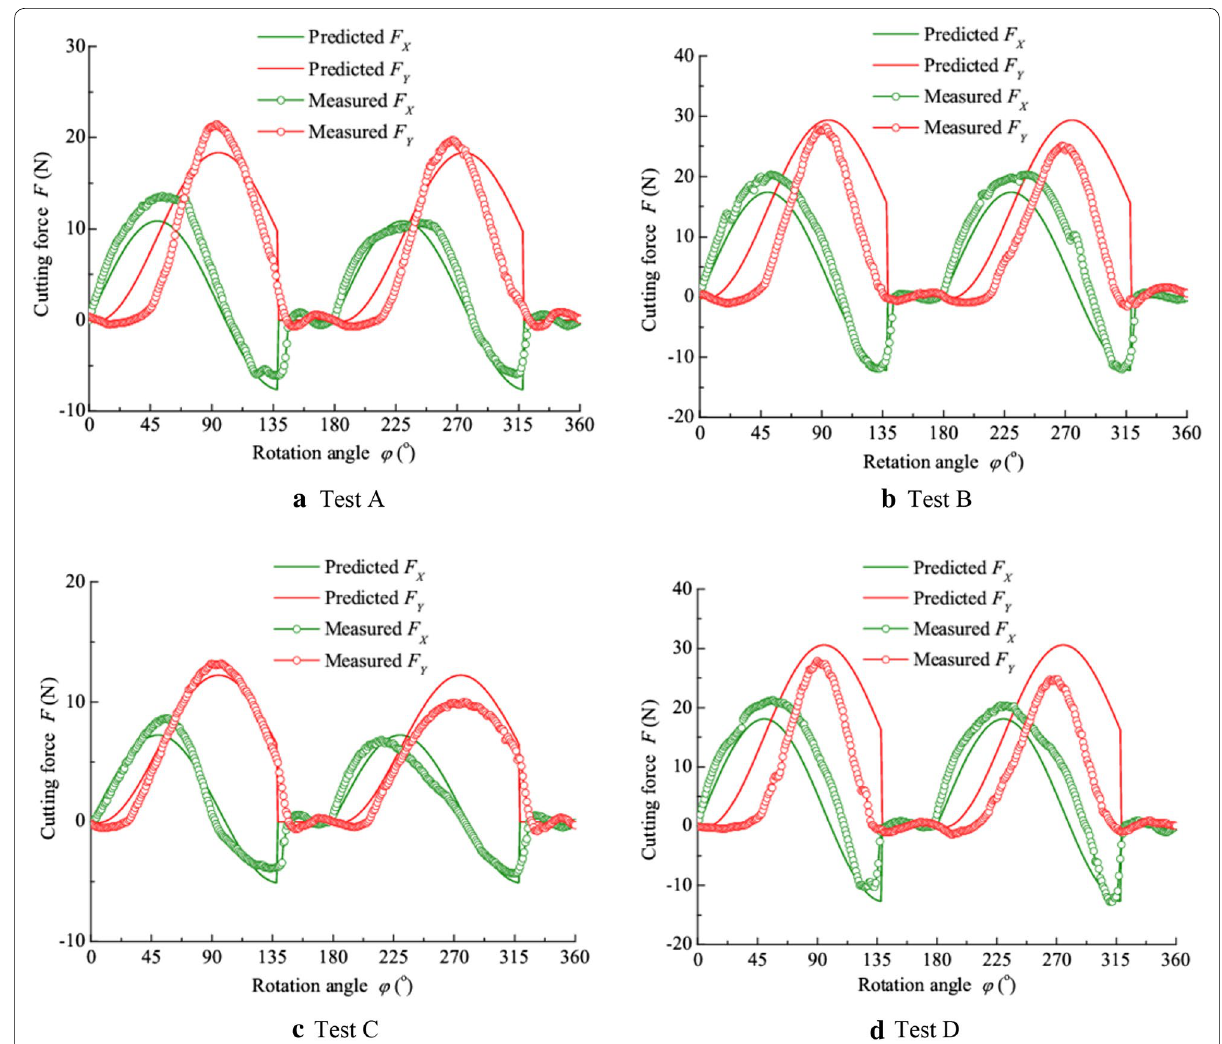
Figure 8 Predicted and measured cutting